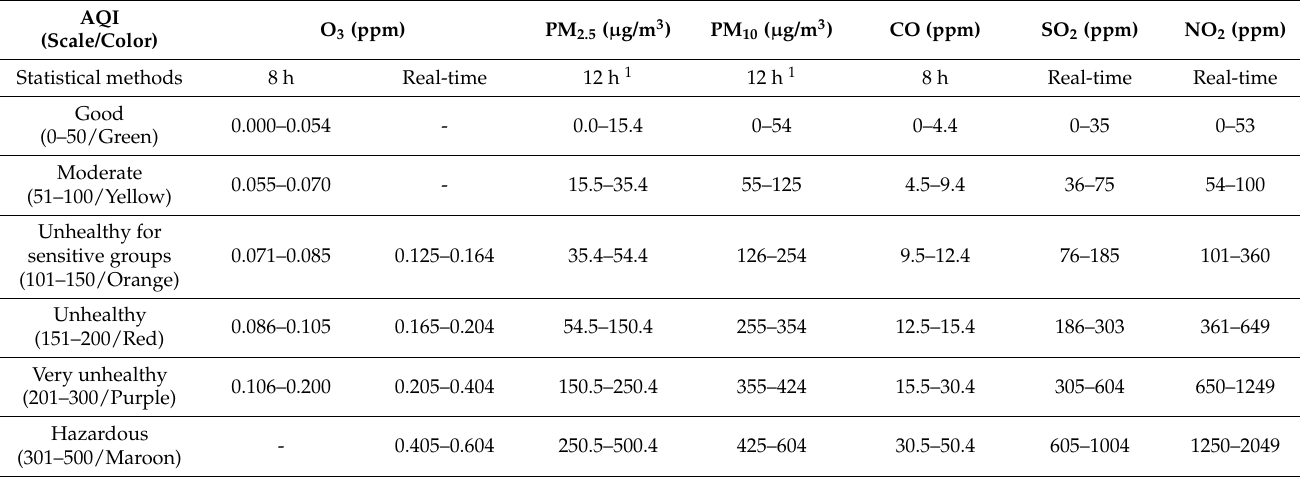
Table 2. Scaled levels of Taiwan’s air quality index (AQI) and corresponding